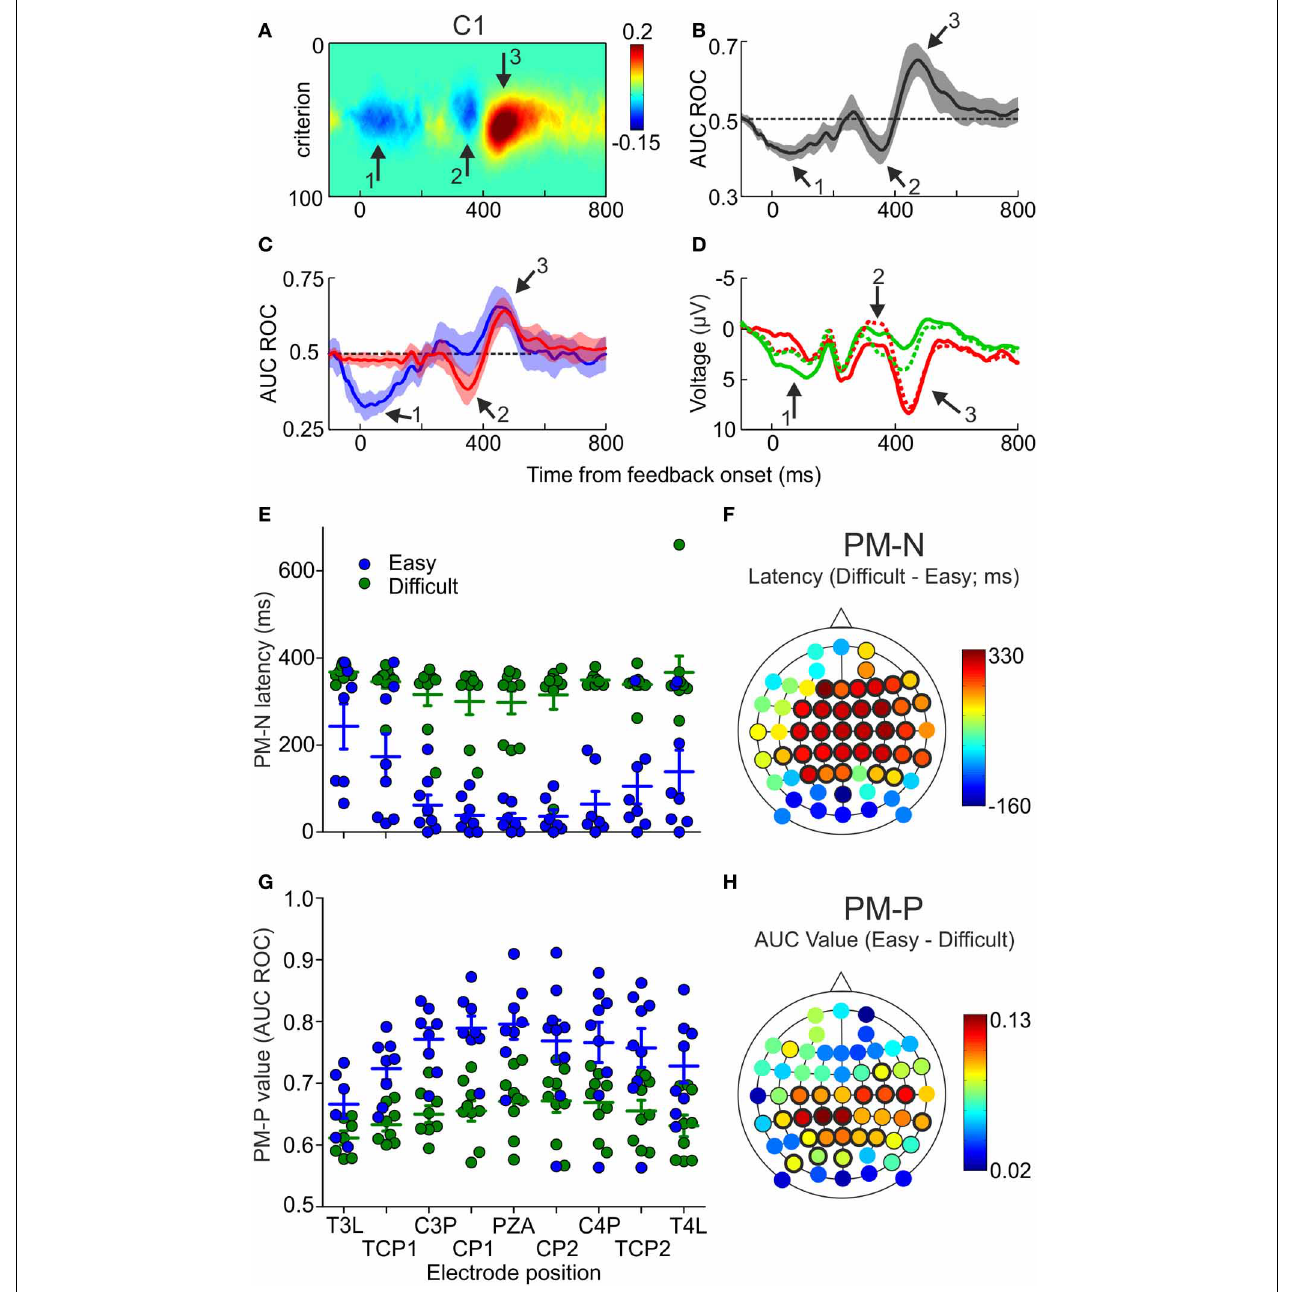
FIGURE 4 | Differences in PM-N and PM-P components as a function of the difficulty of the decisions. (A) Difference between p FAs and p Hits averaged across the sample ( N = 12), as a function of time and criterion, estimated at electrode C1. Arrows 1 and 2 signal the two negative and arrow 3 the positive relevant periods. (B) AUC ROC ( Mean ± 2 s . e . m . ), comparing the voltage recorded at electrode C1 after correct and incorrect trials, averaged across the sample ( N = 12), as a function of time. (C) AUC ROC curves ( Mean ± 2 s . e . m . ), comparing the voltage recorded at different electrodes after correct and incorrect trials, averaged across the sample ( N = 9) as a function of time and difficulty of the discriminations; blue and red lines represent the AUC ROC for easy and difficult discriminations, respectively. (D) Mean voltage as a function of time, recorded at electrode C1, averaged across the sample ( N = 9), for easy correct (green solid line), easy incorrect (red solid line), difficult correct (green dashed line) and difficult